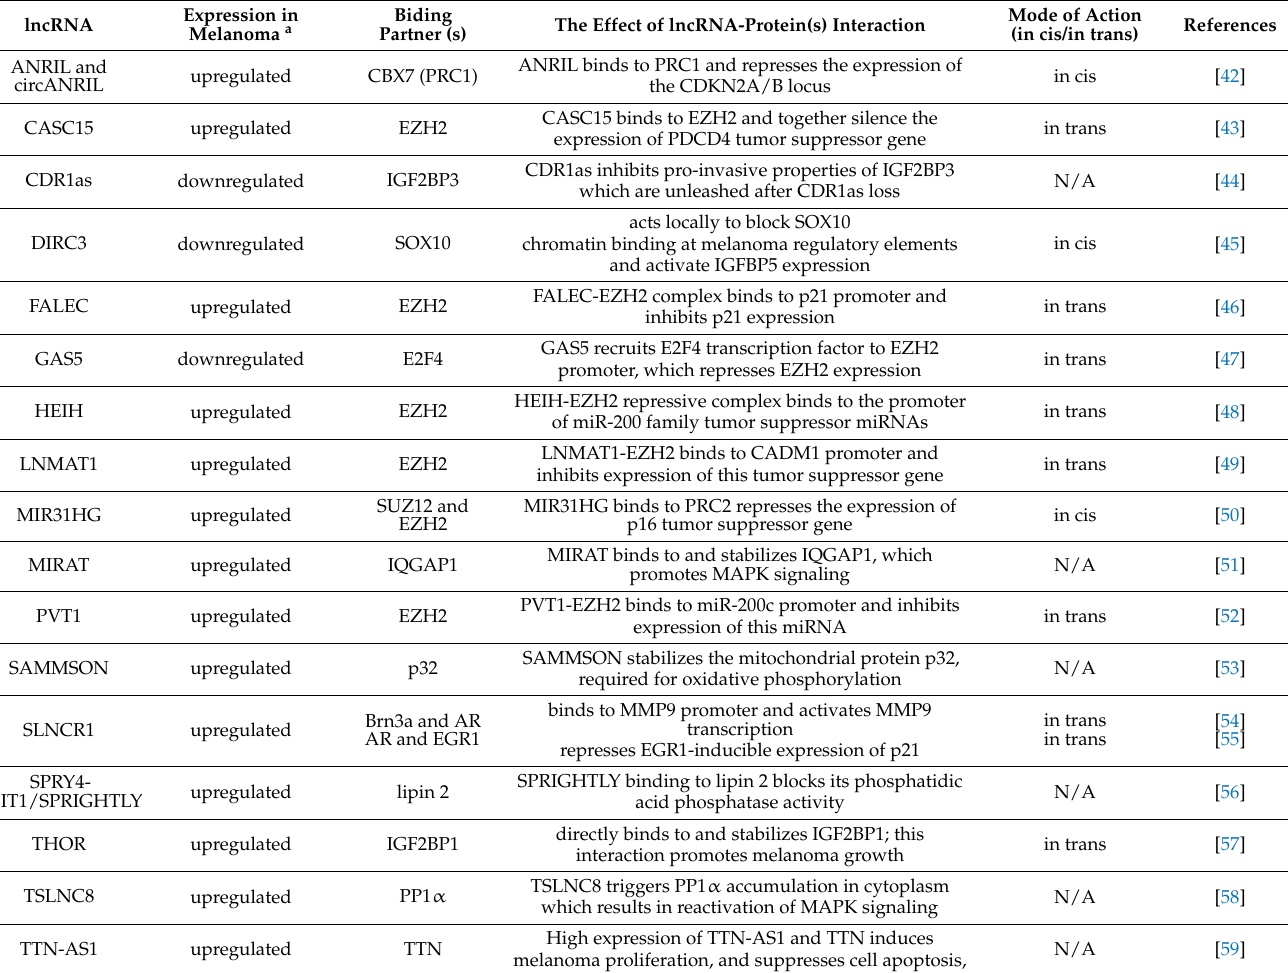
Table 1. Protein-lncRNA interactions in